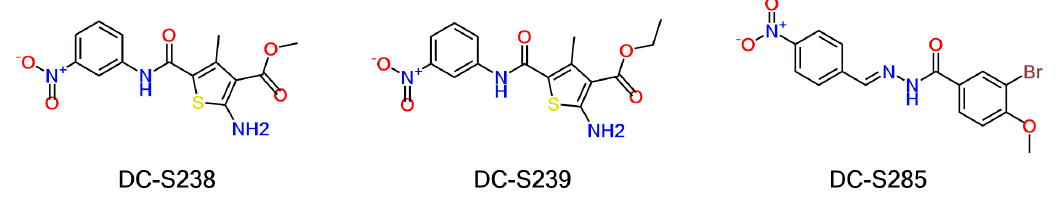
Figure 2. Chemical structures of DC-S238, DC-S239 and DC-S285.